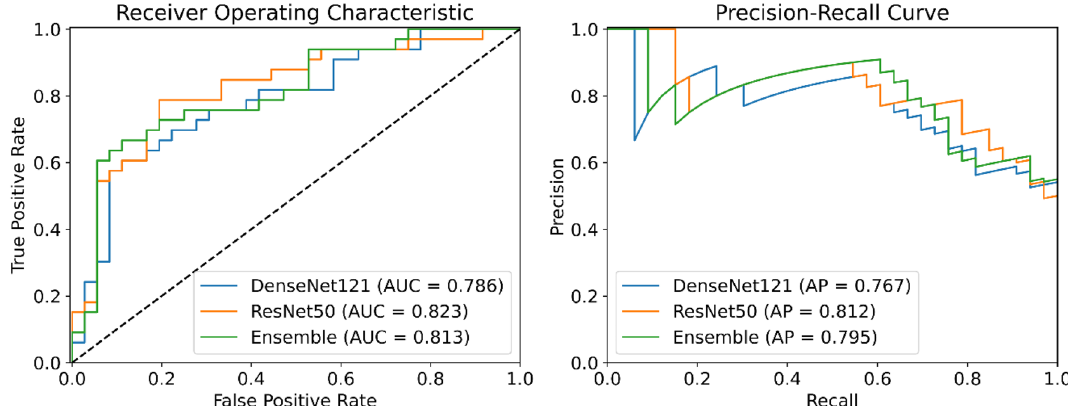
Figure 2. Receiver operating characteristic and precision-recall analysis for the classification performance of DenseNet121 and ResNet50, both trained with unfrozen pre-trained parameters. Abbreviations: AUC area under the curve, AP average precision.